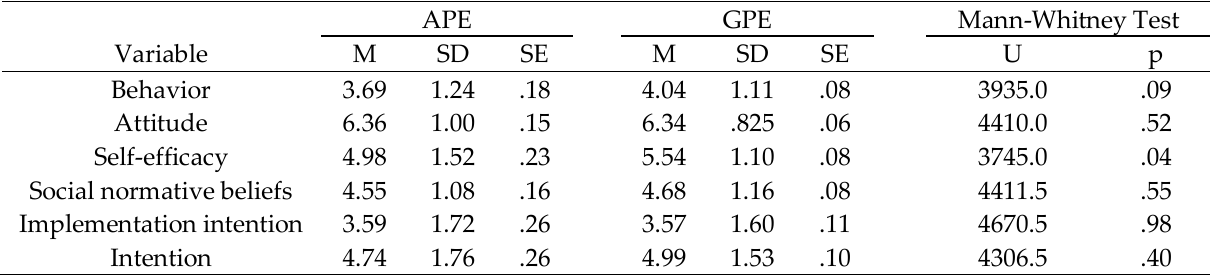
Table 3. Descriptive Properties of Major Outcome Variables